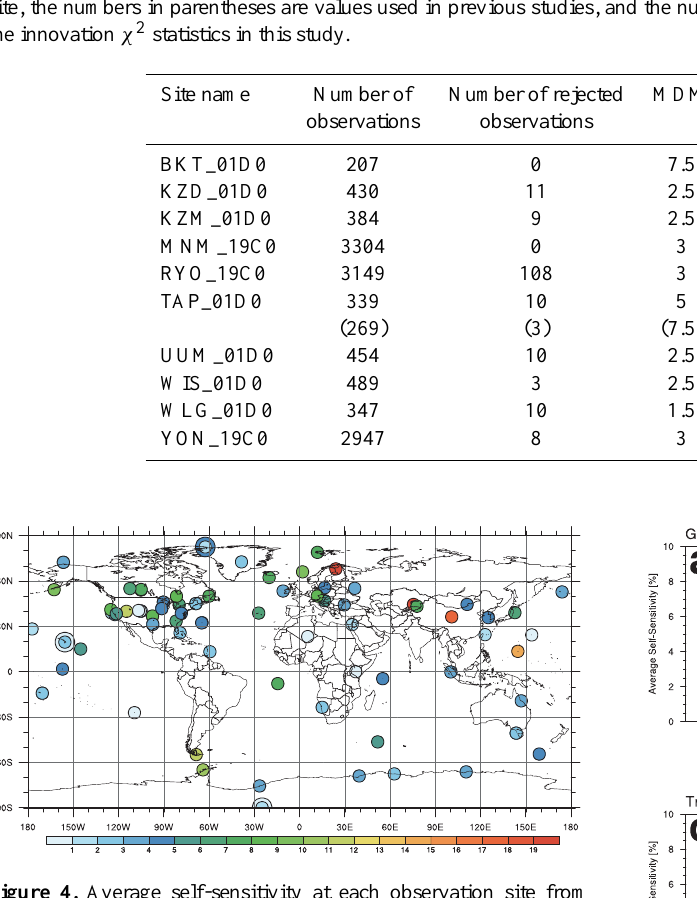
Figure 4. Average self-sensitivity at each observation site from 2001 to 2009. The overlapping observation sites at the same loca- tions or at close locations are distinguished by different sizes of circles.